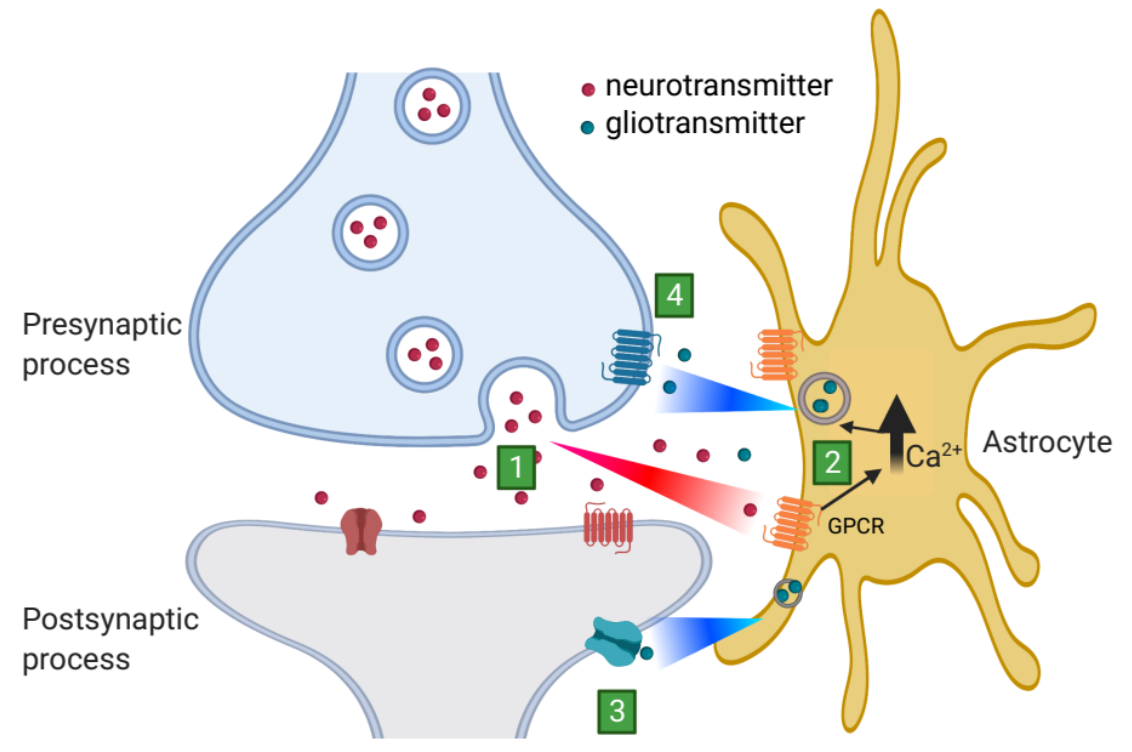
Figure 1. Schematic representation of a tripartite synapse. The tripartite synapse is composed of presynaptic and postsynaptic processes with astrocytic processes enwrapping the synapses. (1) The release of neurotransmitter from the presynaptic terminal acts on the postsynaptic terminal as well as with astrocytic receptors mediating intracellular calcium elevation via G-protein coupled receptors (GPCRs). (2) Then, calcium elevation triggers the release of gliotransmitters that bind with the postsynaptic terminal receptors (3) or presynaptic receptors (4) to modulate synaptic transmission .